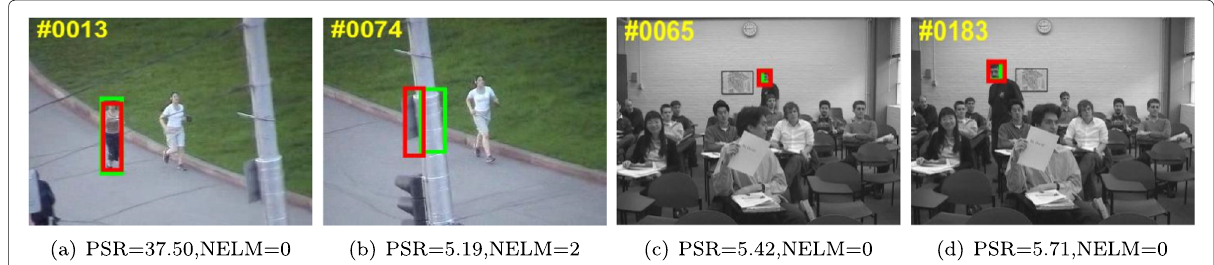
Fig. 3 “Jogging-1”, “Freeman3” sequences with the PSR and NELM. The red bounding boxes indicate the tracking results by our method. a PSR = 37.50, NELM = 0. b PSR = 5.19, NELM=2. c PSR = 5.42, NELM = 0. d PSR = 5.71, NELM =